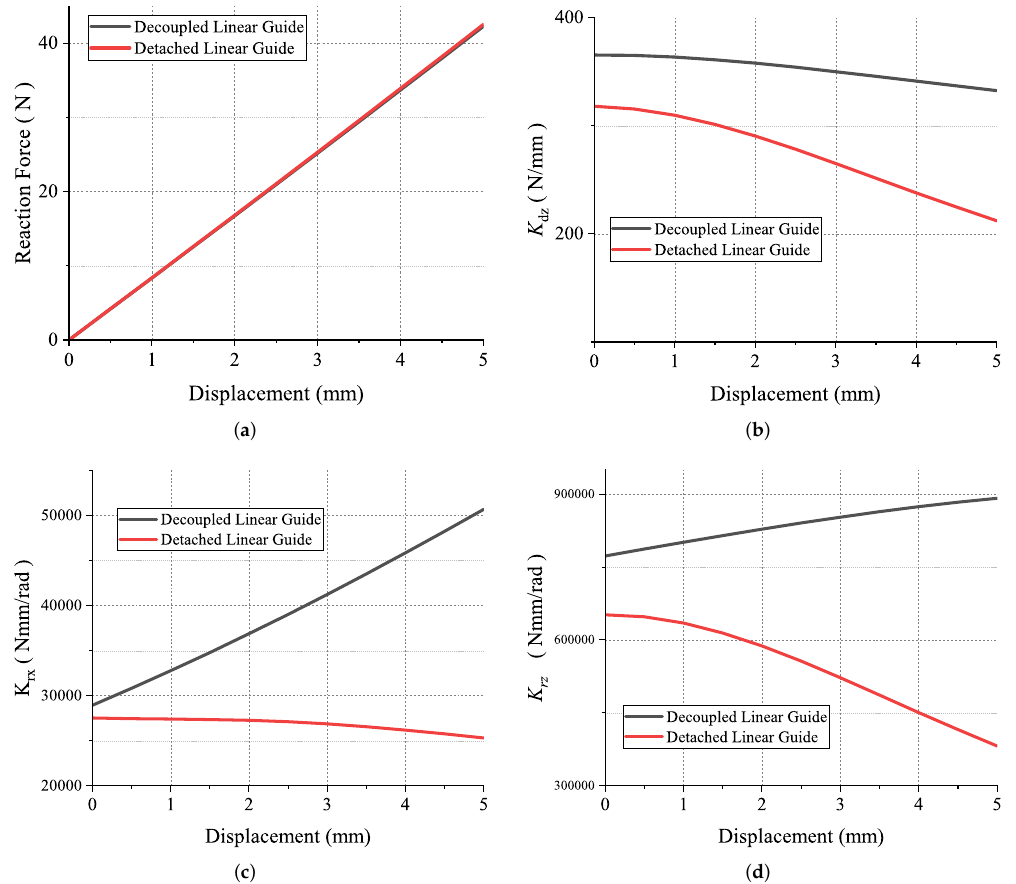
Figure 6. The comparison between the decoupled linear guide and the detached linear guide. The results are derived from the nonlinear FEA simulation. ( a ) The linear relationship between reaction force and displacement along motion direction. ( b ) The translational stiffness along Z-axis. ( c ) The rotational stiffness along X-axis. ( d ) The rotational stiffness along